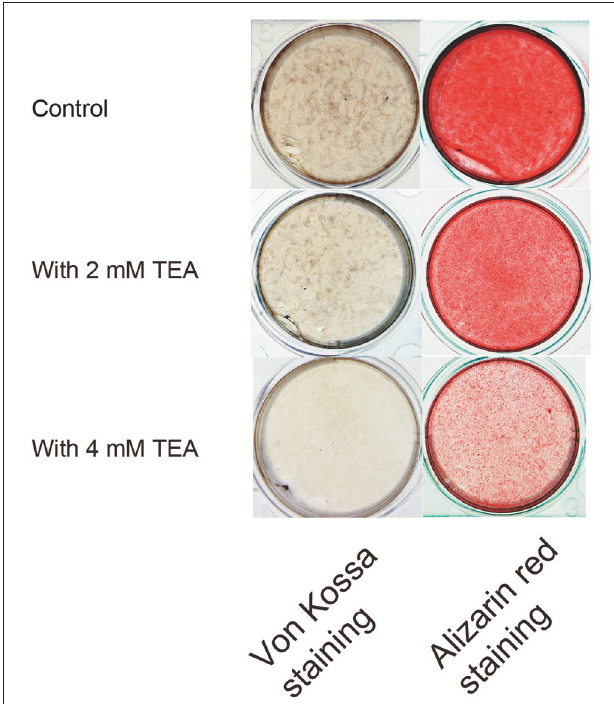
FIGURE 4 | Effect of K + channel activity on the mineralization. Photographs show the von Kossa (left panels) and alizarin red (right panels) staining, without (controls; upper panels) or with 2mM (middle panels) or 4mM (lower panels)